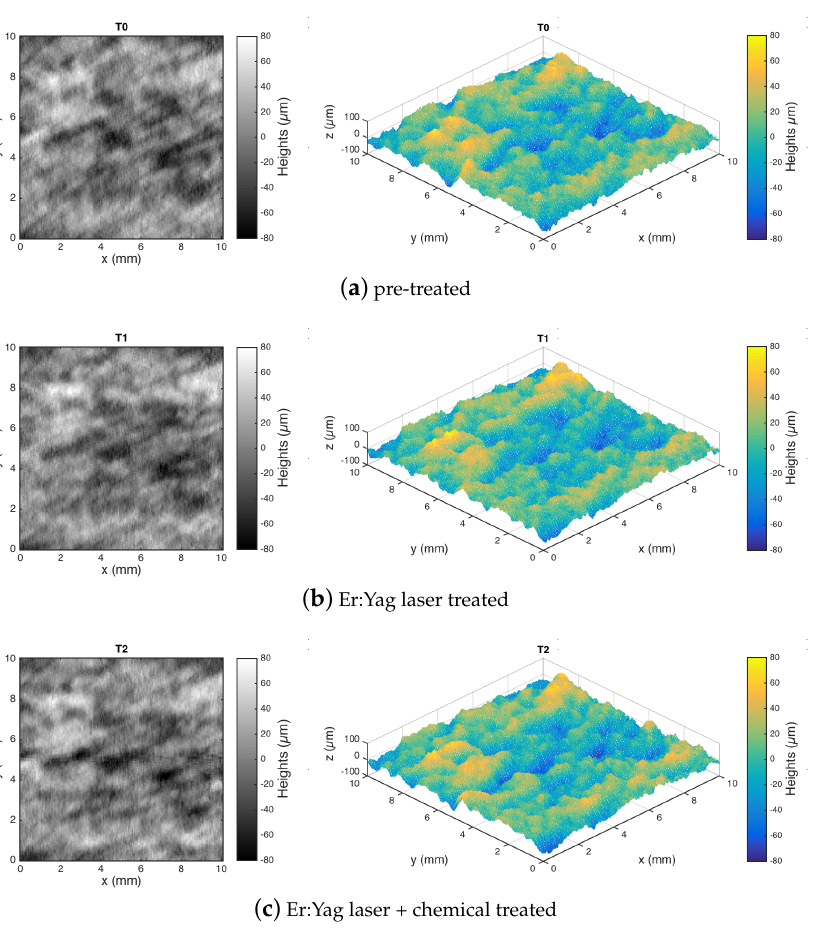
Figure 5. Experiment 1-dataset ( b ). Evolution of a single azurite ROI at different surface processing steps: surface data plotted as intensity maps and 3D